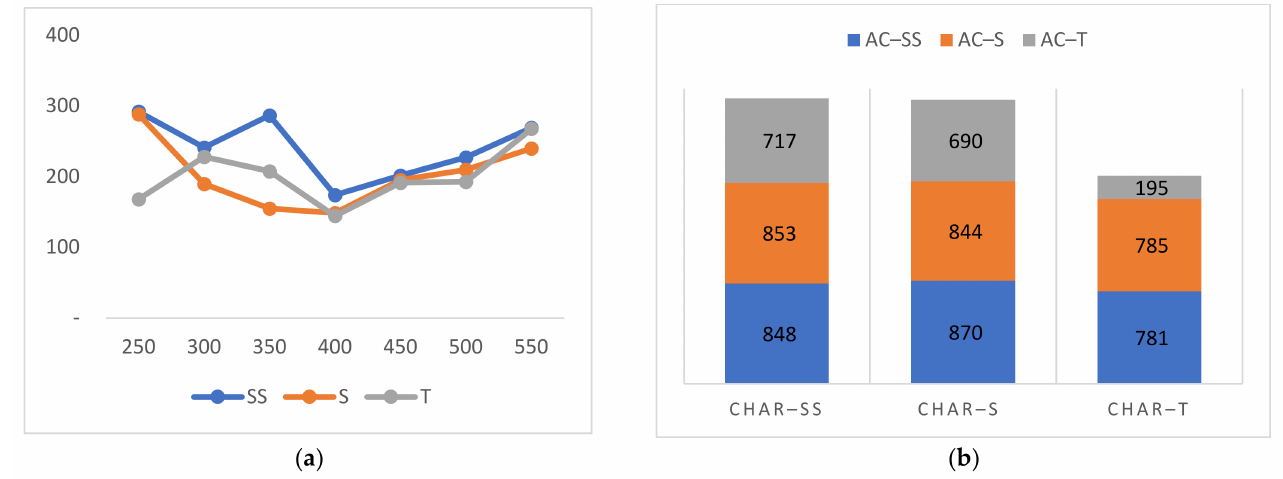
Figure 4. Iodine adsorption performance mg/g. ( a ) pyrochar, ( b ) activated